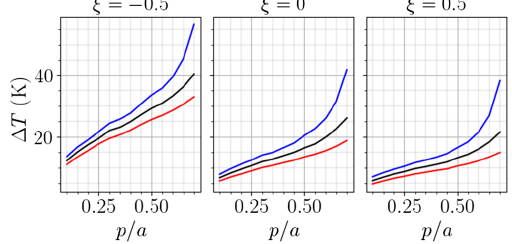
100 MVm − 1 , acc ¼